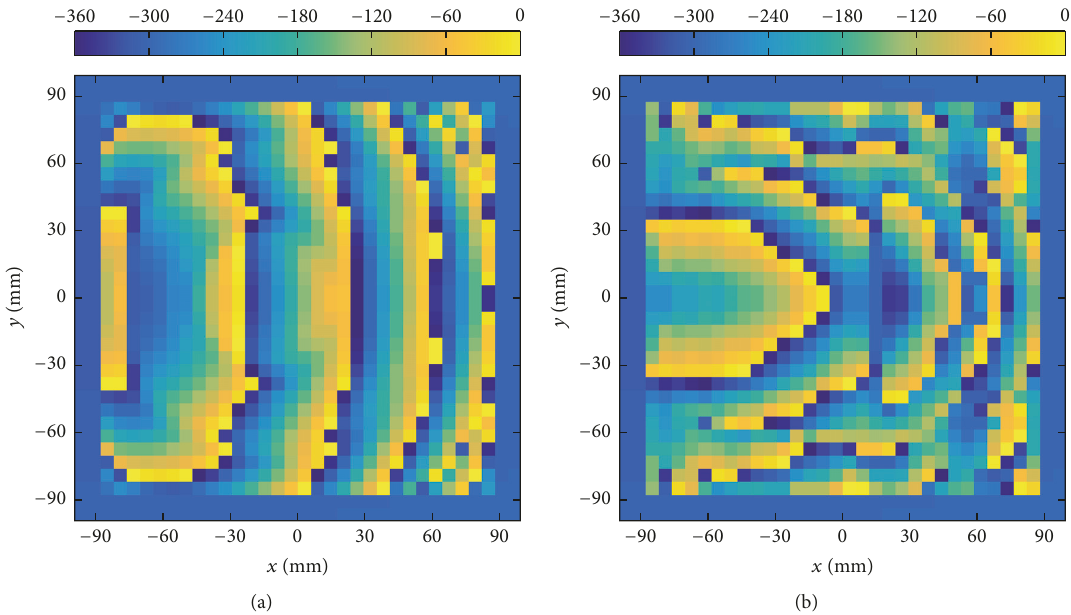
Figure 7: Synthesized phase distribution on the reflectarray surface including the dielectric frame with 𝑁 𝑓 = 3 , corresponding to the (a) isoflux and (b) LMDS patterns for 𝑋 polarization.